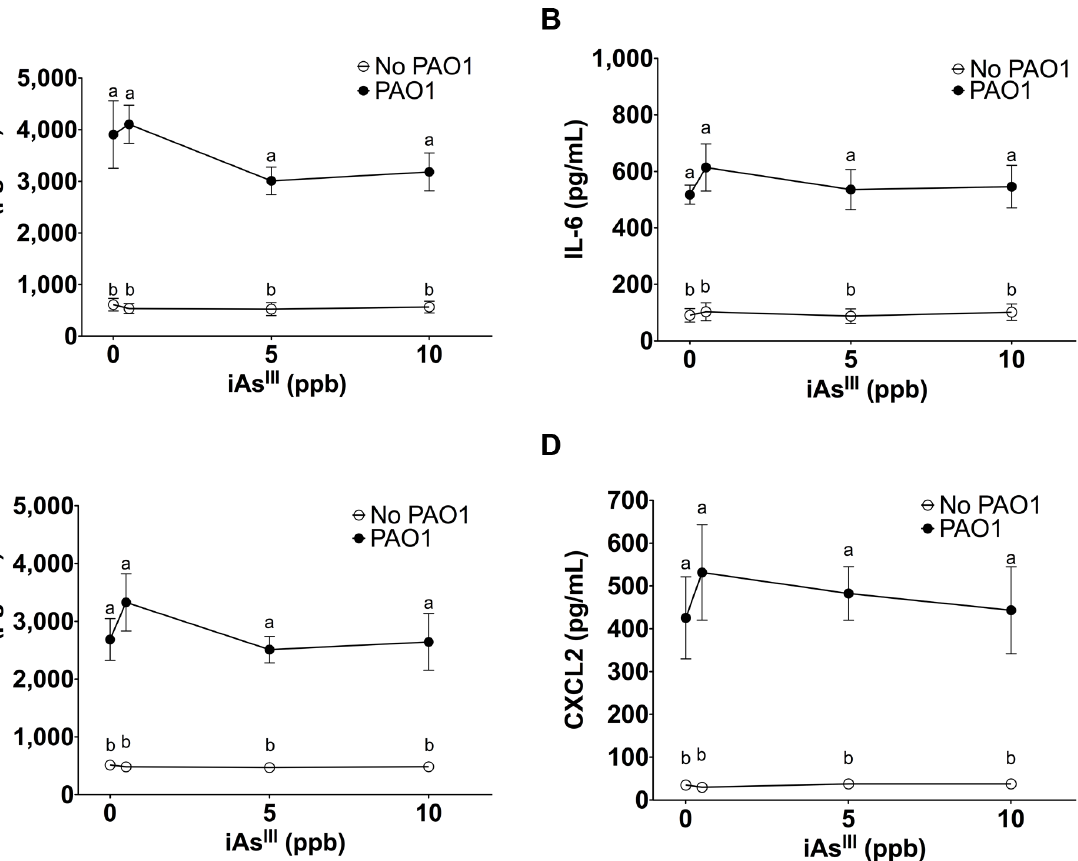
Fig 2. Inorganic arsenic does not alter P . aeruginosa induced immune response. Cytokine secretion by HBEC exposed to iAs III ± P . aeruginosa . n = 4 donors for each treatment. Different letters indicate statistically significant treatment means. Data labeled a are not statistically different from each other but are statistically different from data labeled b (p < 0.05 as measured by one-way ANOVA). Data with the same letter are not significantly different. (A) IL-8 secretion (B) IL-6 secretion (C) CXCL1 secretion (D) CXCL2 secretion.